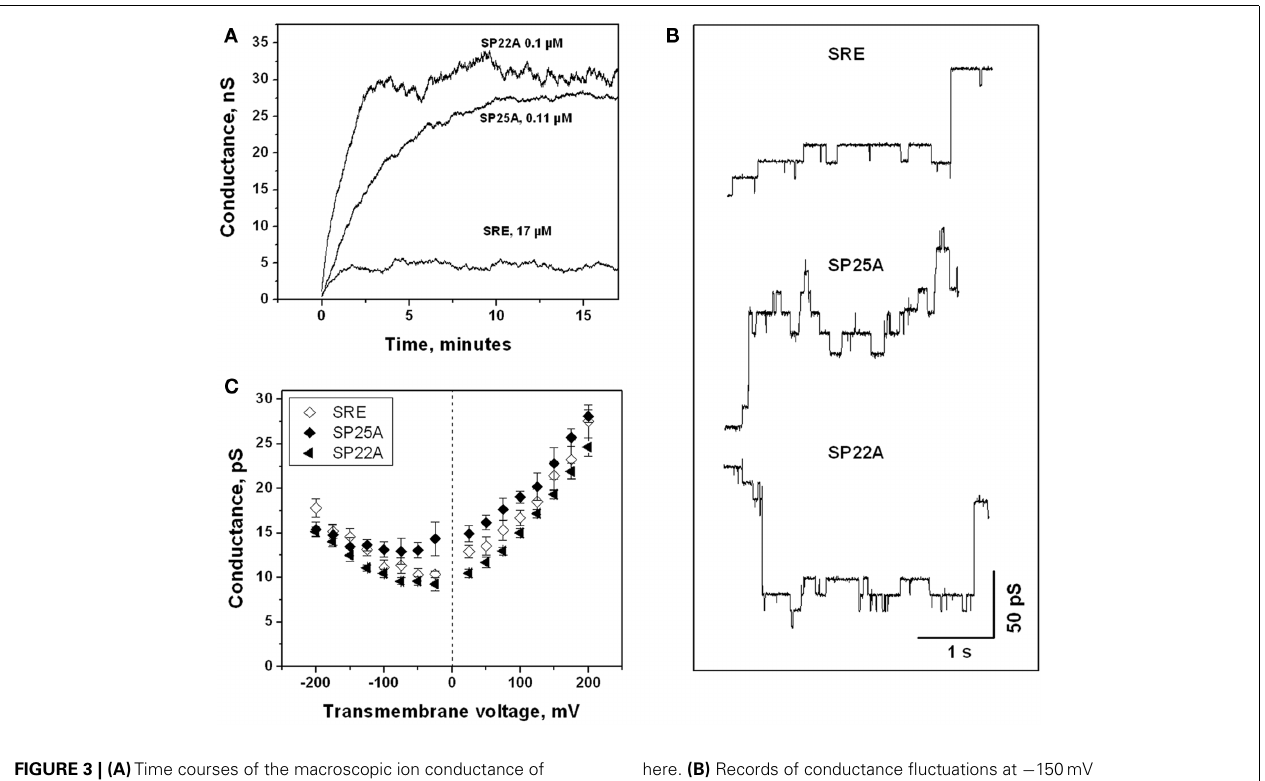
FIGURE 3 | (A) Time courses of the macroscopic ion conductance of bilayers doped with SRE, SP22A, and SP25A, recorded at the applied voltage of − 100mV.Ten individual observations were made for each compound and concentration with one representative trace shown